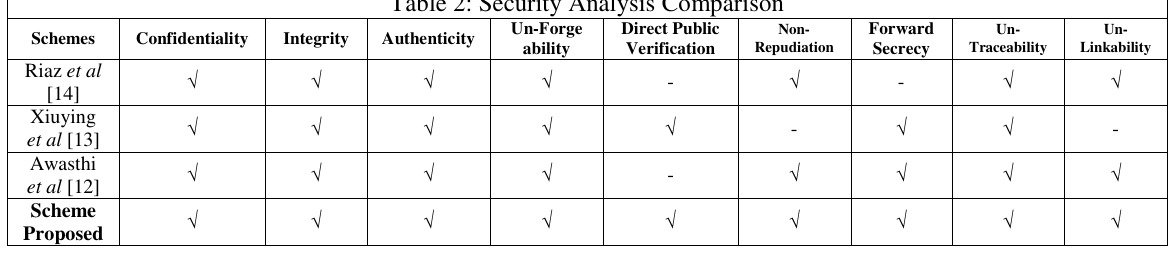
Table 2: Security Analysis